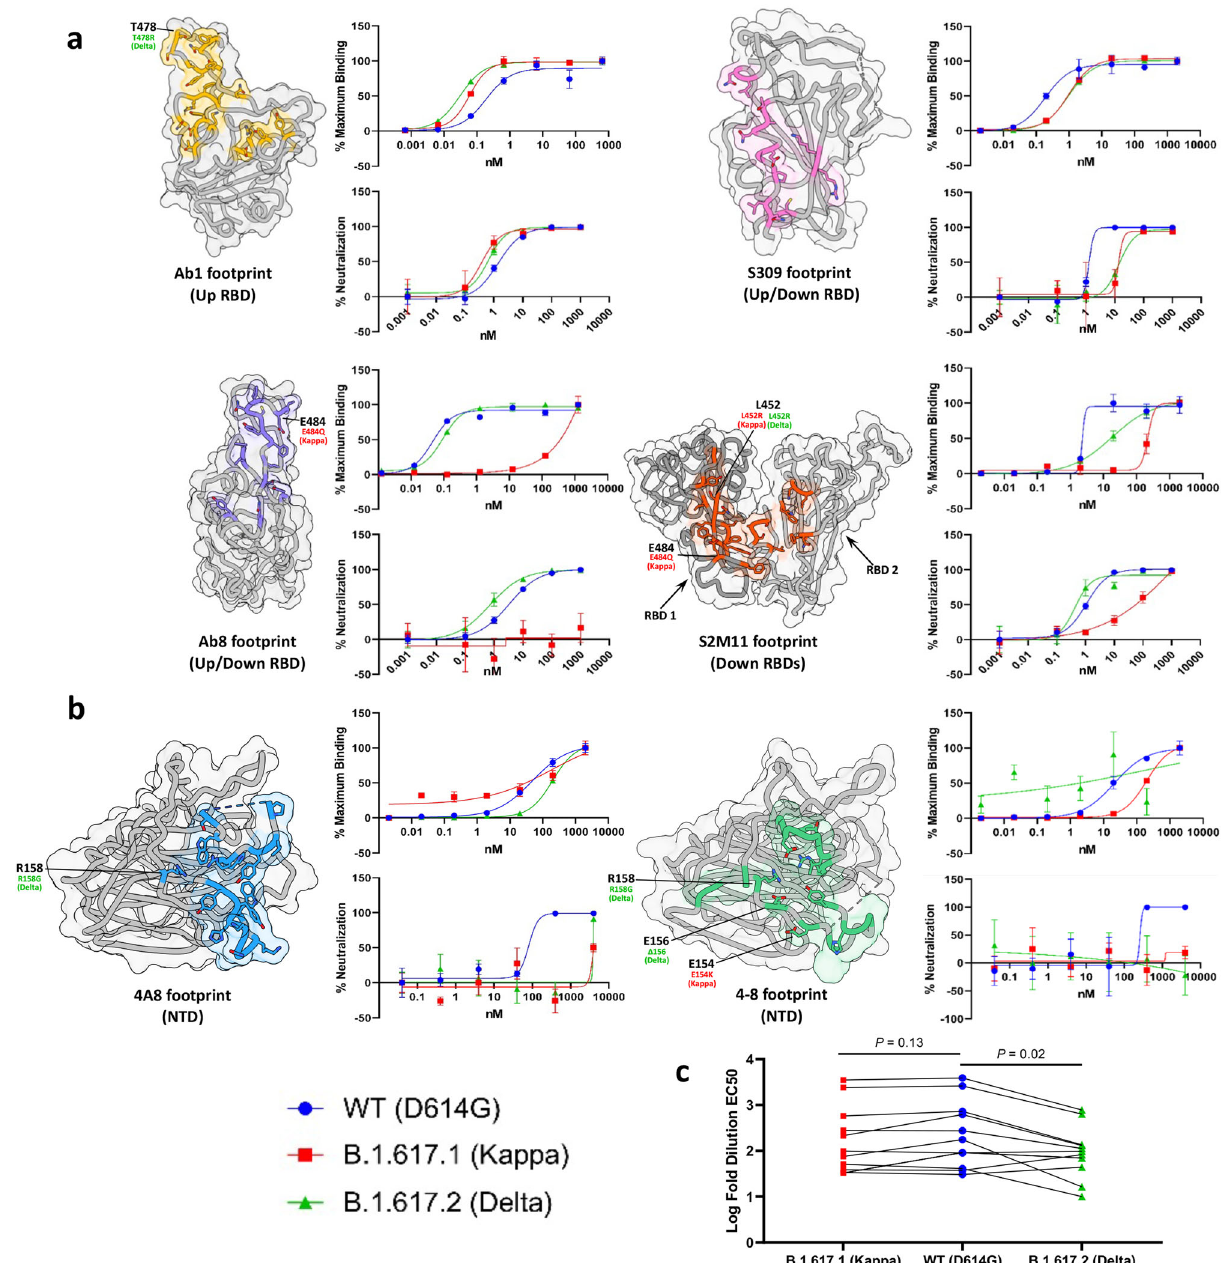
Fig. 2 Antibody evasion by Delta and Kappa variants. a Antibody-binding footprints, antibody binding as assessed by ELISA, and pseudovirus neutralisation for four anti-RBD antibodies (Ab1 - PDB ID: 7MJJ, Ab8 - PDB ID: 7MJH, S309 – PDB ID: 6WPS, and S2M11 – PDB ID: 7K43). Both ELISA and pseudovirus neutralisation assays were performed at least in technical duplicate and the mean is plotted. Error bars represent standard deviation. b As in a but for two anti-NTD antibodies (4A8 - PDB ID: 7C2L and 4 – 8 - PDB ID: 7LQV) Both ELISA and pseudovirus neutralisation assays were performed at least in technical duplicate and the mean is plotted. Error bars represent standard deviation. c Log fold dilutions of sera conferring 50% neutralisation (EC 50 ) of pseudovirus harbouring wild-type, Kappa or Delta spikes, from patients post COVID19 and/or vaccination ( n = 12 patients). Statistical signi fi cance was tested via the Wilcoxon matched-pairs test (two-tailed). Patient-derived sera sample information and raw pseudovirus neutralisation data are presented in Supplementary Fig. 15. Source data are provided as a Source Data fi